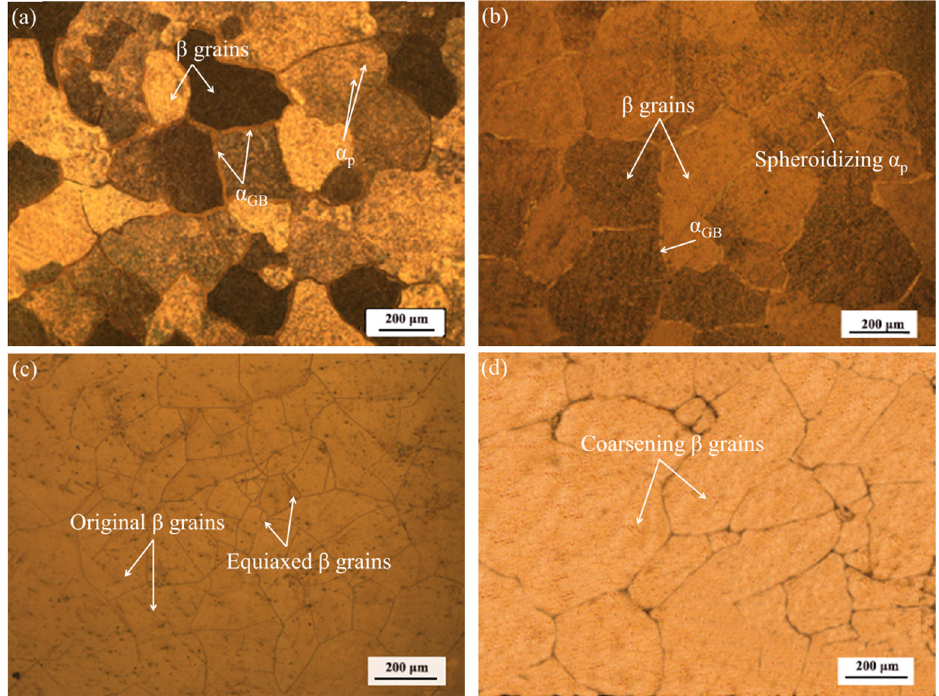
Figure 4: Microstructures of sample solutions treated at different temperatures with air cooling: ( a ) 700°C, ac; ( b ) 760°C, ac; ( c ) 820°C, ac and ( d ) 880°C,